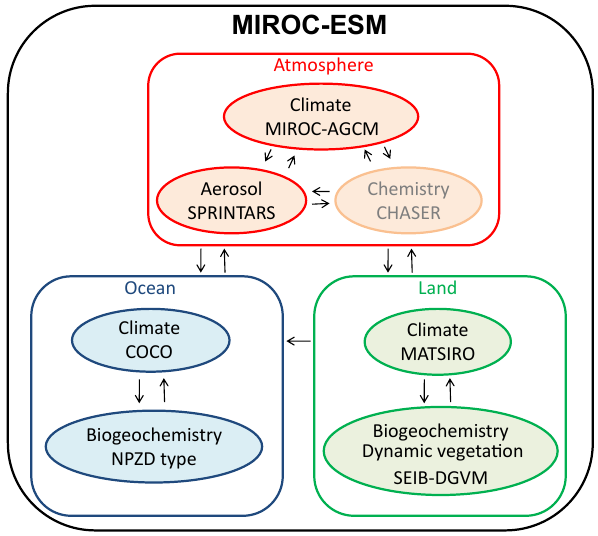
Fig. 1. The structure of MIROC-ESM. It consists of an atmo- spheric GCM (MIROC-AGCM) with an online aerosol compo- nent (SPRINTARS) and a chemistry component (CHASER), an Figure 1. The structure of MIROC-ESM. It consists of an atmospheric GCM (MIROC-4 ocean GCM with sea ice component (COCO), a land surface model (MATSIRO), and terrestrial and marine ecosystem components AGCM) with an on-line aerosol component (SPRINTARS) and a chemistry component 5 (SEIB-DGVM and NPZD-type model). Paleoclimate experiments (CHASER), an ocean GCM with sea-ice component (COCO), a land surface model 6 described in this paper were performed without (MATSIRO), and terrestrial and marine ecosystem components (SEIB-DGVM and NPZD-7 type model). Paleoclimate experiments described in this paper were performed without 8 CHASER. 9